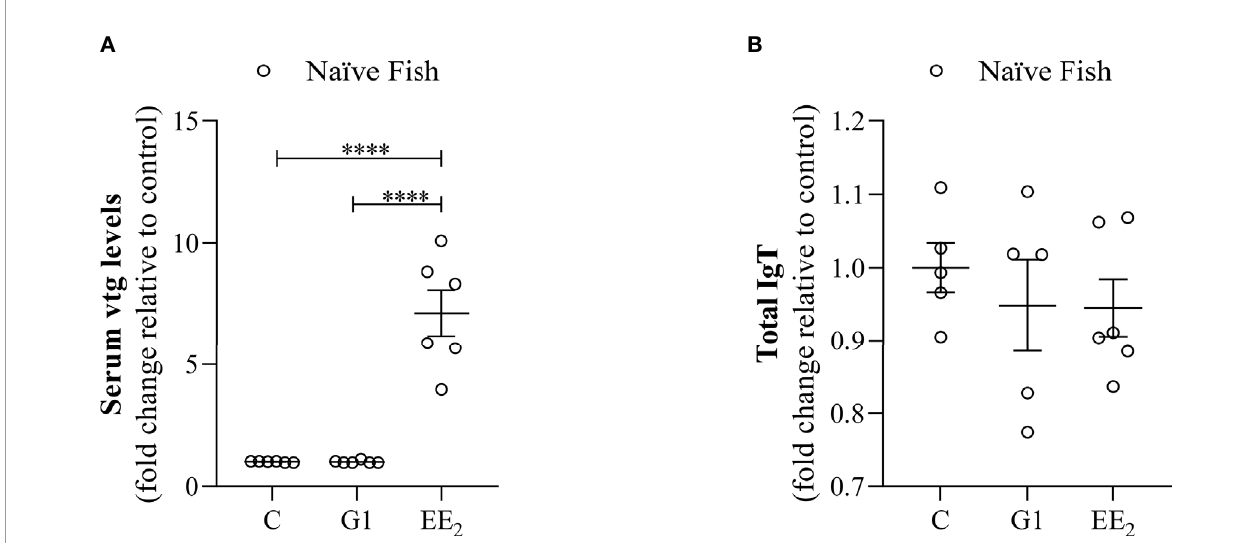
FIGURE 2 | Dietary addition of xenoestrogen impairs vitellogenin but not total IgT production. Serum or intestinal mucus from gilthead seabream which had been treated with G1 or EE2 (5 m g/g food) for 43 days were assayed for: (A) serum vitellogenin (Vtg) level. (B) Intestinal mucus total immunoglobulin T (IgT). Both parameters were assessed with a double speci fi c antibody procedure by ELISA. Representative ± SEM are shown (n = 6). The asterisks denote statistically signi fi cant differences after Student ’ s t-test between each treated and the untreated groups.